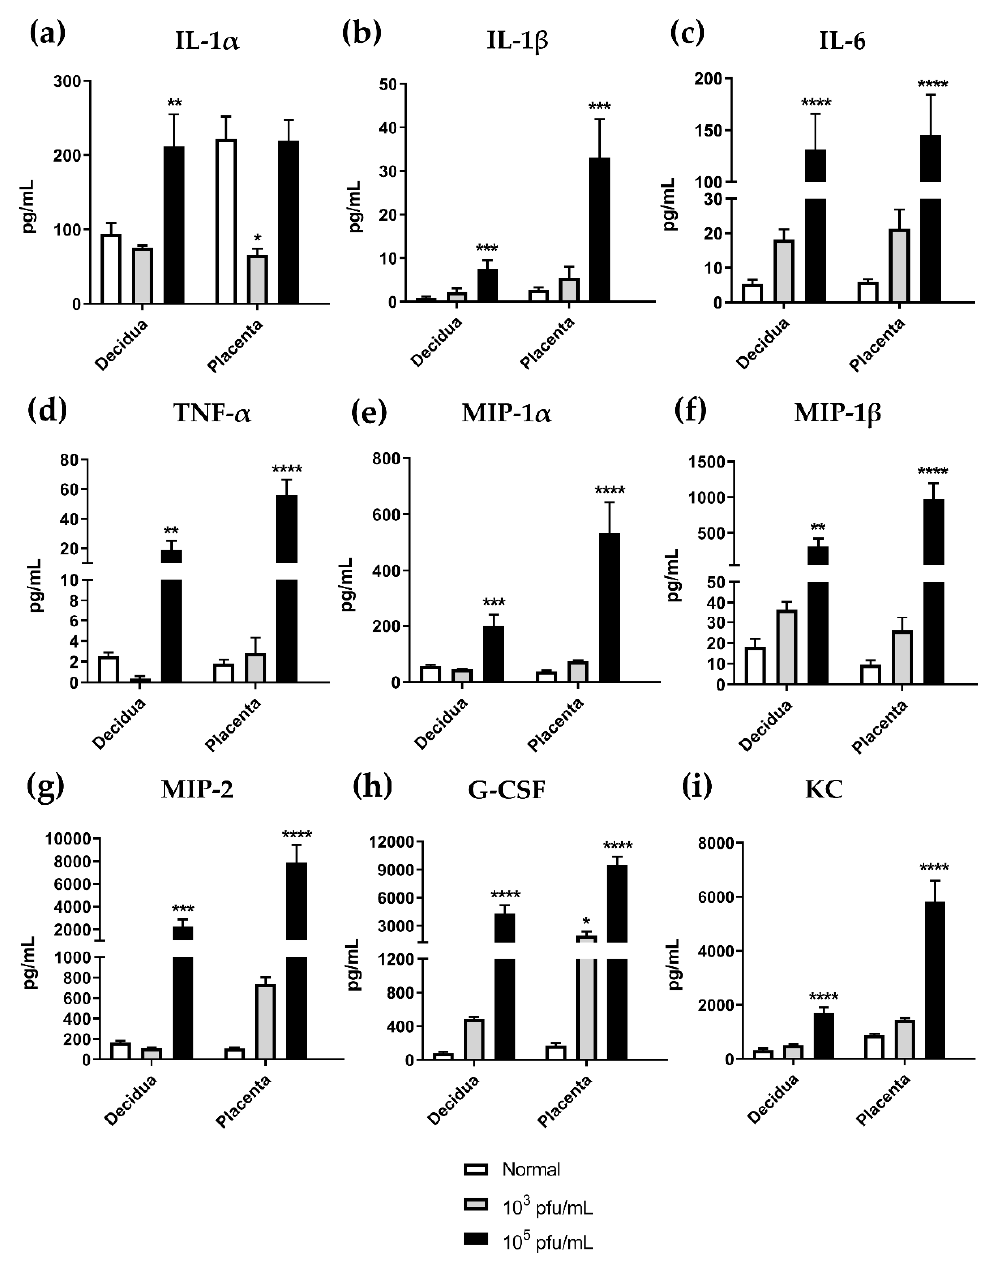
Figure 7. HSV ‐ 2 infection alters cytokine/chemokine profiles in the decidua and placenta at gd12.5. Cytokines in tissue homogenates from normal mice and mice infected with low (10 3 pfu/mL) and high (10 5 pfu/mL) dose HSV ‐ 2 were analyzed by 32 ‐ plex array and 9 analytes were selected for further analysis: ( a ) IL ‐ 1 α , ( b ) IL ‐ 1 β , ( c ) IL ‐ 6, ( d ) TNF ‐α , ( e ) MIP ‐ 1 α , ( f ) MIP ‐ 1 β , ( g ) MIP ‐ 2, ( h ) G ‐ CSF, and ( i ) KC. ( a ) IL ‐ 1 α was significantly increased in the decidua of high dose infected animals and significantly decreased in the placenta of low dose infected animals. ( b – i ) Compared to normal controls, high dose HSV ‐ 2 infection significantly increased cytokine/chemokine levels in decidua and placenta homogenates. ( h ) Compared to controls, G ‐ CSF was significantly increased in placenta tissue homogenates with both low and high dose HSV ‐ 2 infection. Data expressed as mean ± SEM. * p < 0.05 , **p < 0.01 , ***p < 0.001 , **** p < 0.0001. 3.7. In Utero HSV ‐ 2 Transmission into Fetuses is Observed at gd12.5 and is Accompanied by